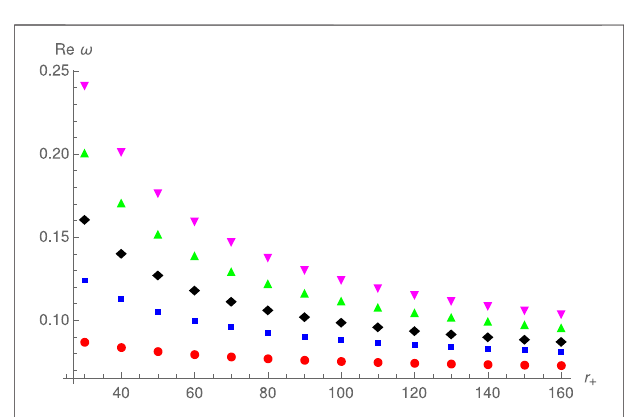
FIGURE5| Forthe fi rstfiveQNFsoftheKlein-Gordon fi eldweshowhow the real part depends on the radius of the 2D black hole (2). We consider a Klein-Gordon fi eld of mass m (cid:1)